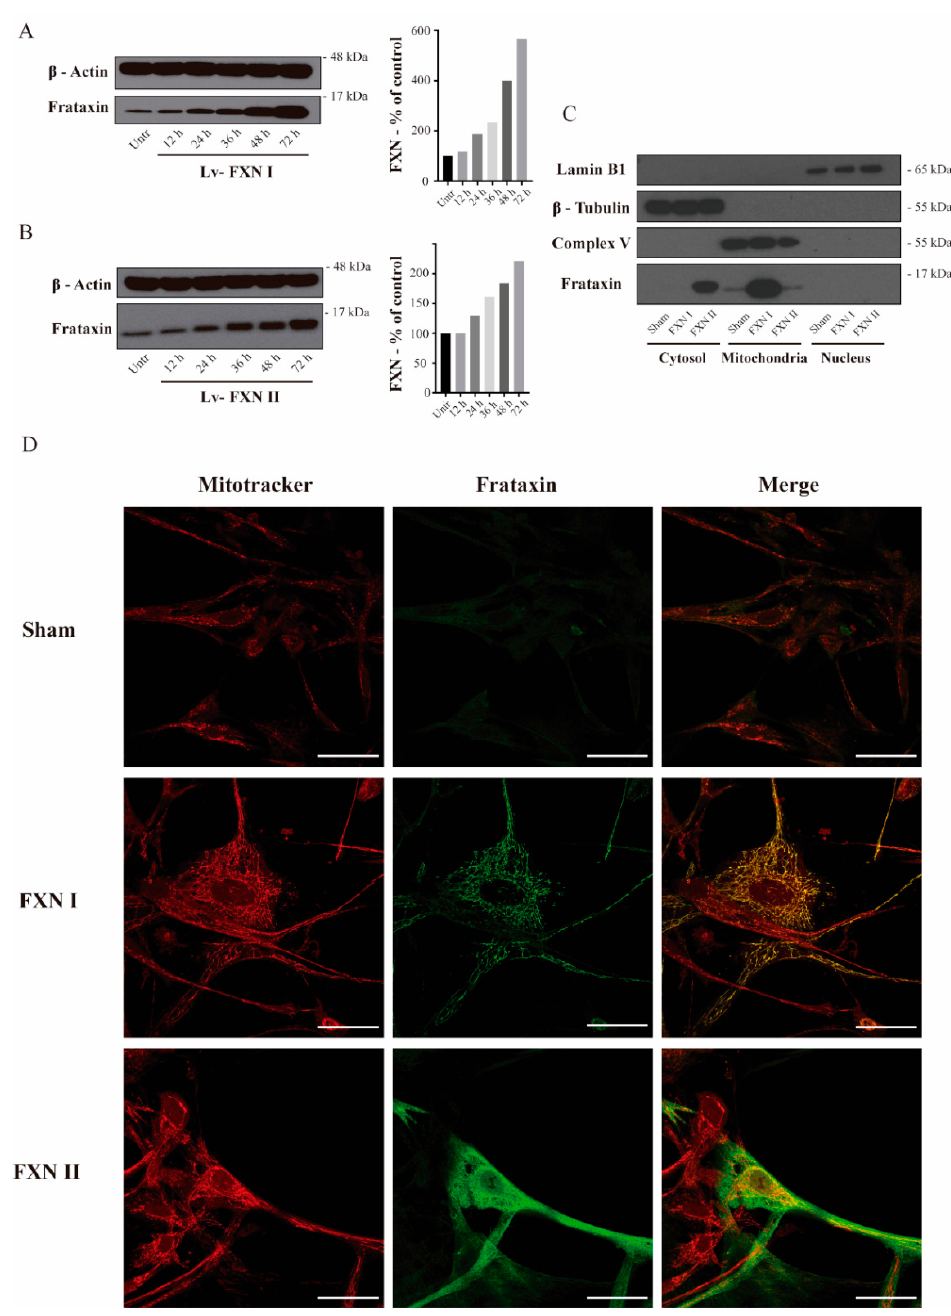
Figure 1. Intracellular localization of frataxin isoform I and II in FRDA-derived OE-MSCs. ( A ) to ( B ) OE-MSCs from FRDA patient transduced for 48 h before cell fractionation with either Lv-FXN I ( A ) or Lv-FXN II ( B ). ( C ) Subcellular fractionation of patient-derived OE-MSCs transduced with lentivectors codifying for FXN isoforms. Specific markers were used to identify the appropriate subcellular compartment: Lamin B1 for nucleus, Complex V (ATP-Synthase) for mitochondrion and β -tubulin for cytoplasm. ( D ) Representative confocal photomicrographs showing FRDA-derived OE-MSCs that were left untreated, or transduced with Lv-FXN I or Lv-FXN II, and stained with Mitotracker (Red) and frataxin (Green). The merged panels show mitochondrial co-localization between frataxin isoform I and Mitotracker, and the cytosolic localization of frataxin isoform II. Calibration bar represents 50 µm.